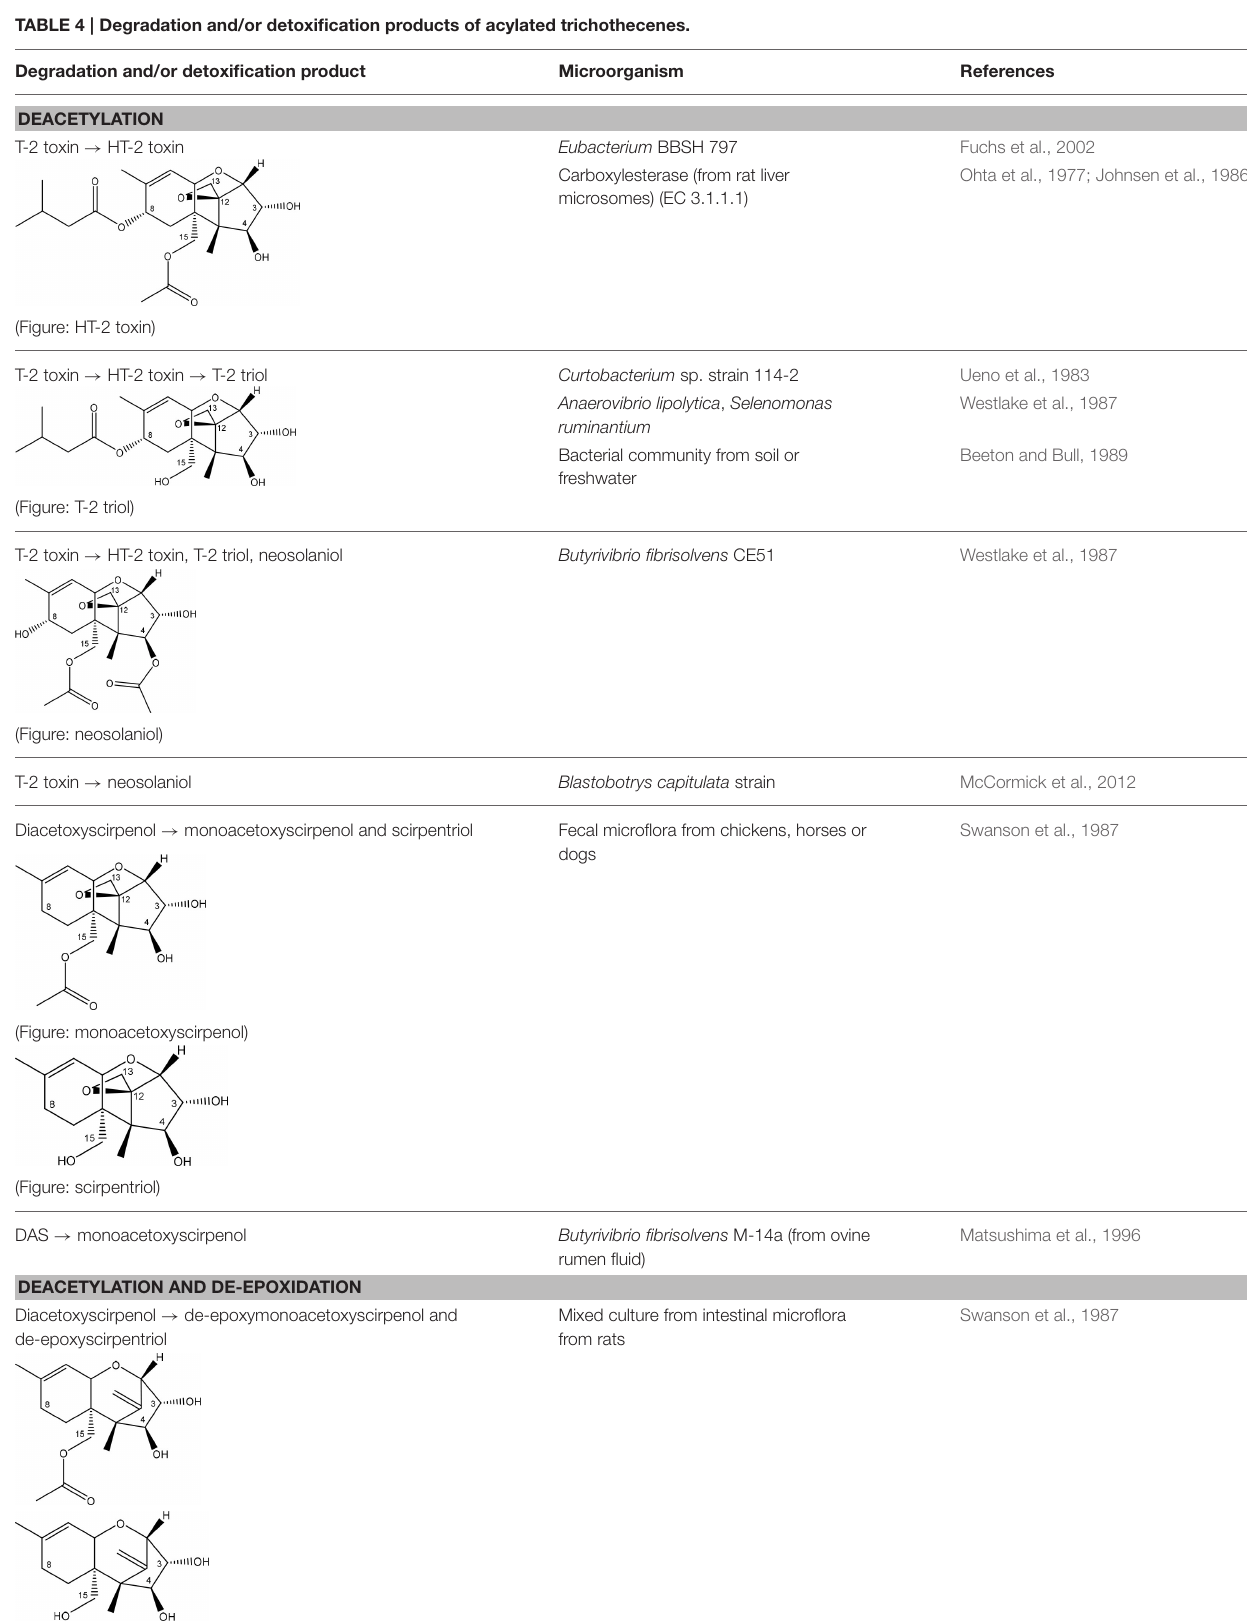
TABLE 4 | Degradation and/or detoxification products of acylated trichothecenes. Degradation and/or detoxification product